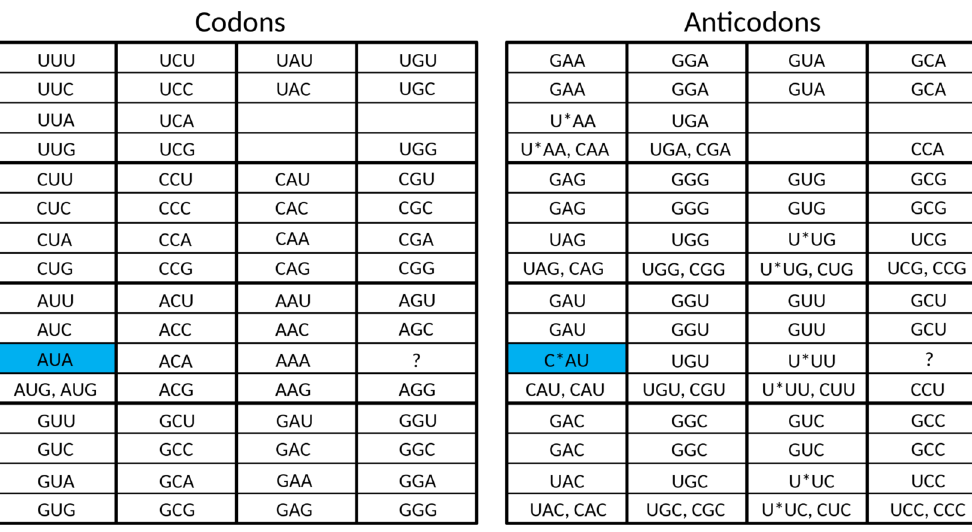
Fig 6. The tRNA set of present-day Archaea. The asterisks indicate anticodon first position modifications which are necessary to unambiguously read the respective codon box. The only difference with the proposed tRNA set of LUCA is the presence of the codon AUA in this codon repertoire (indicated by coloring with blue).